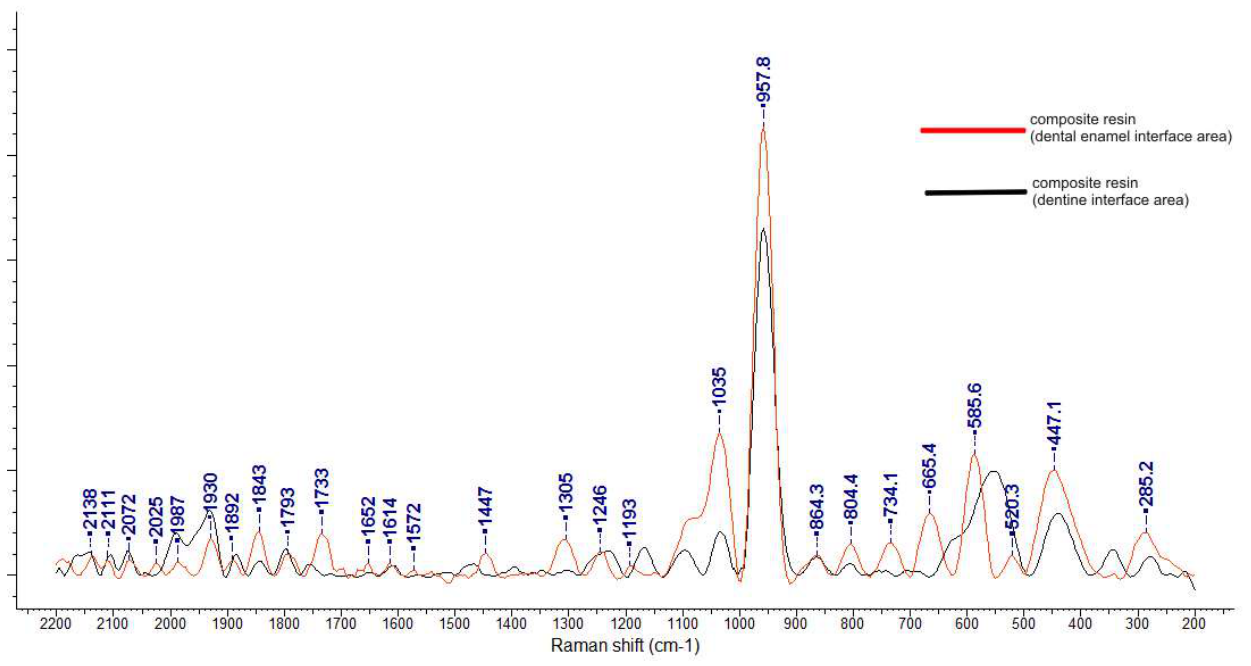
Figure 4. Raman spectra of the enamel-resin interface and dentin-resin interface.